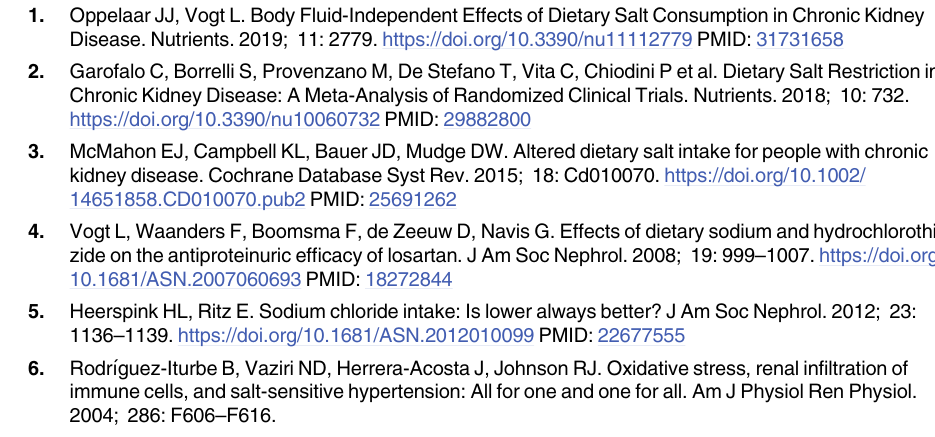
37 kDa (surrounded by red squares) was increased in the IR group (n = 8) especially on day1 (D1) while no or little IgM-free AIM was detected in the “Pre” condition. In contrast, in the HS-loaded condition (HS-IR group, n = 8), the levels of IgM-free AIM after IR were lower than those in the IR group. IgM-bound AIM and backgrounds are surrounded by blue and green squares, respectively. The serum from AIM KO mice are also presented as negative con- trols besides HS-IR#6, 8 and IR#7, 8. Calculated IgM-free AIM concentration ( μ g/mL) is pre- sented under each band. S1 Table. qPCR primer